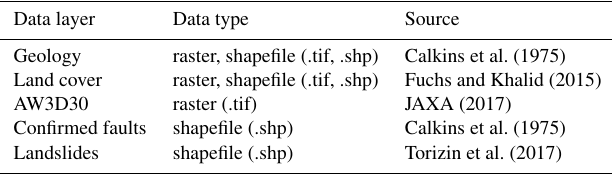
Table 2. Overview of the datasets in the test